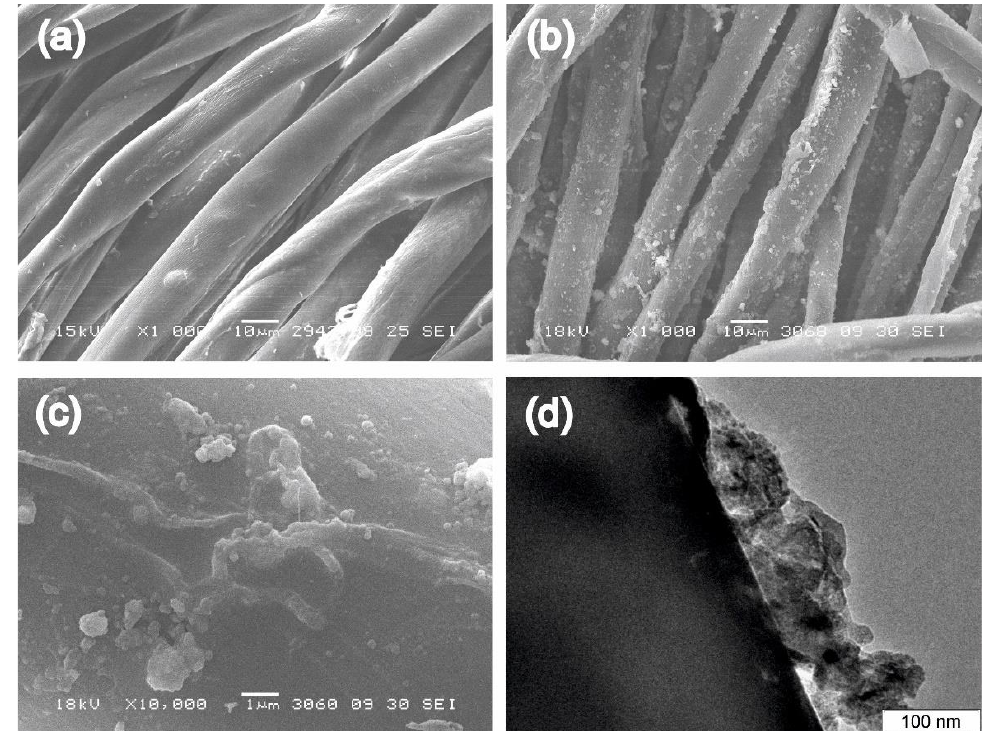
Figure 1. SEM images of initial cotton ( a ) and cotton functionalized with nanocrystalline TiO 2 ( b , c ); TEM cross-view image of cotton fiber with attached TiO 2 particles ( d ).